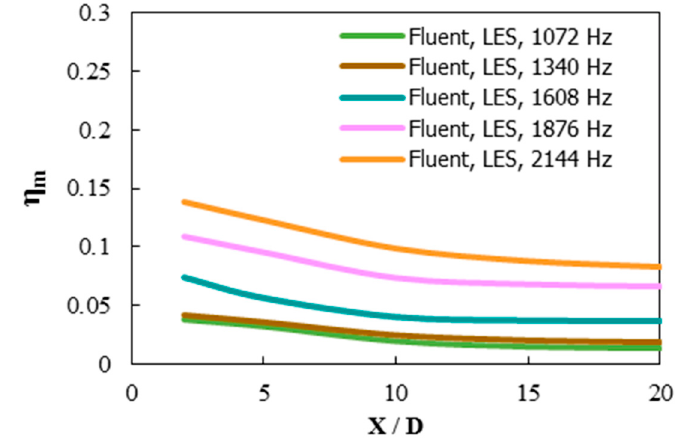
Figure 30. The spanwise-averaged effectiveness obtained using the LES Smagorinsky–Lilly model for M = 0.5 for the 268, 536, 804, and 1072 Hz oscillations [28].